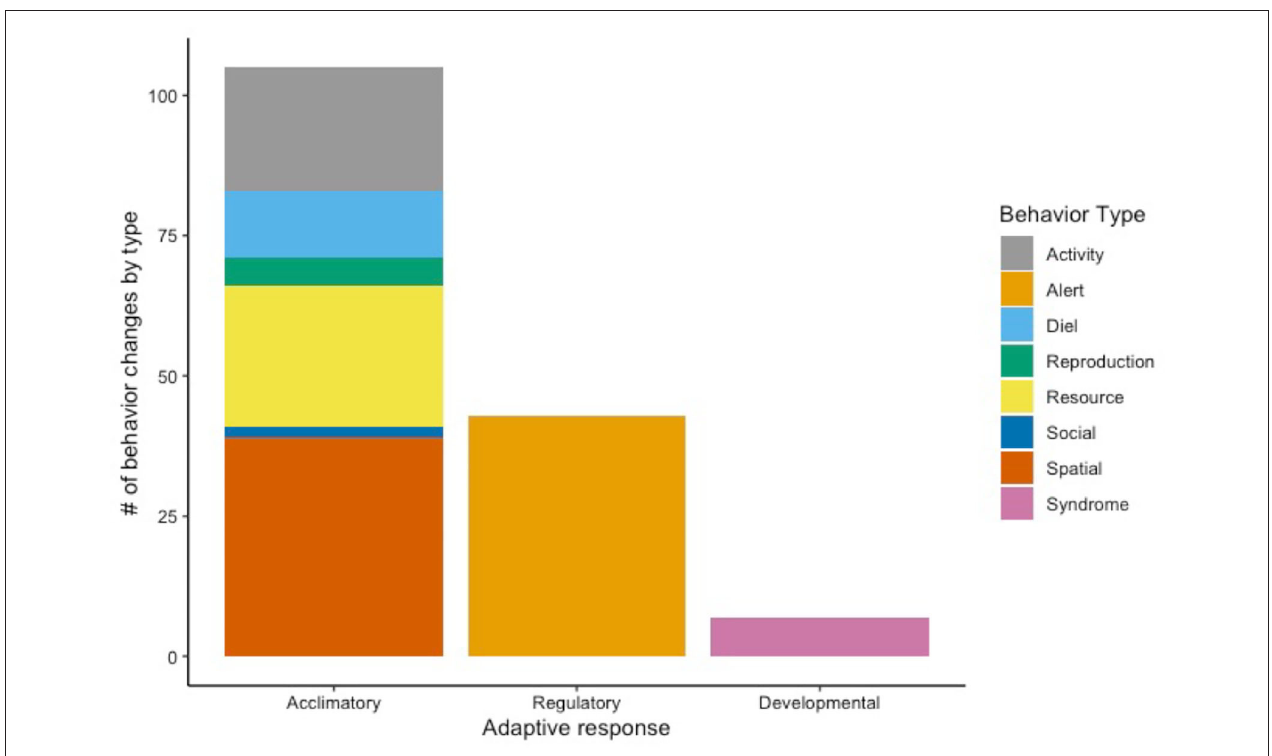
FIGURE 4 | The 8 types of behavior changes observed in urban mammals from 1987 to 2020 categorized by adaptive